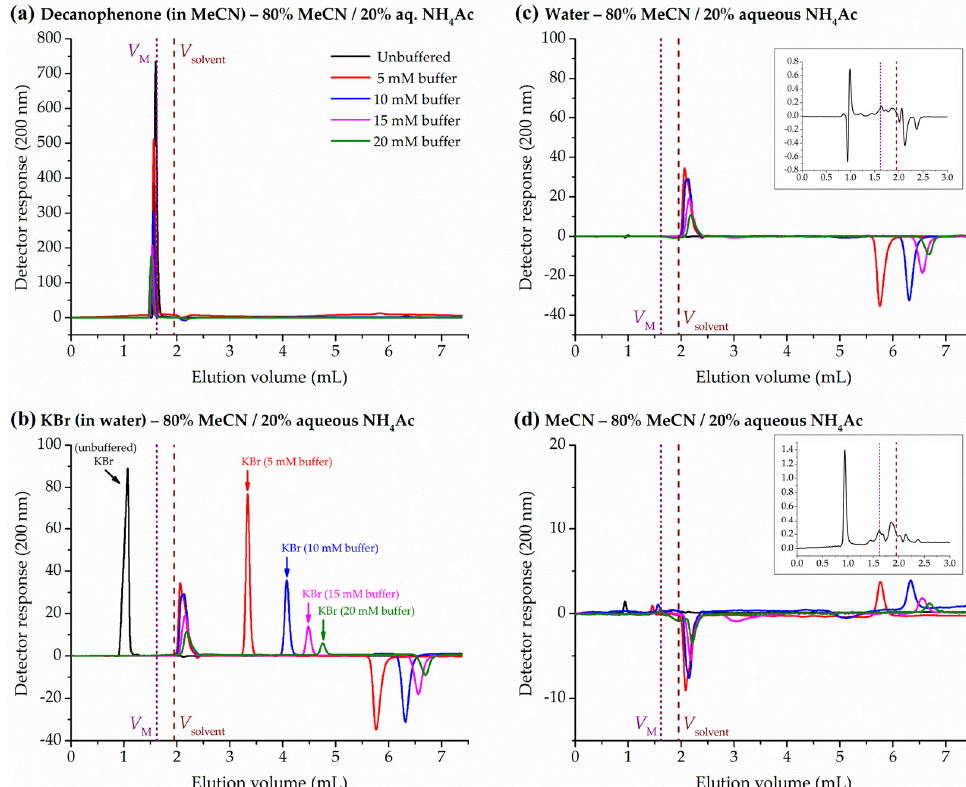
Figure 3. Effect of mobile phase ammonium acetate concentration (80% acetonitrile, MeCN) on the retention of hold-up marker candidates in the ZIC-HILIC column: ( a ) decanophenone, ( b ) potassium bromide, ( c ) water, and ( d ) acetonitrile. Dotted straight line corresponds to the hold-up volume from the homologous series approach ( V M ) and dashed straight line to the solvent volume pycnometrically measured ( V solvent ). Insets in ( c , d ) show the chromatograms corresponding to the injection of water and acetonitrile, respectively, in the unbuffered mobile phase.